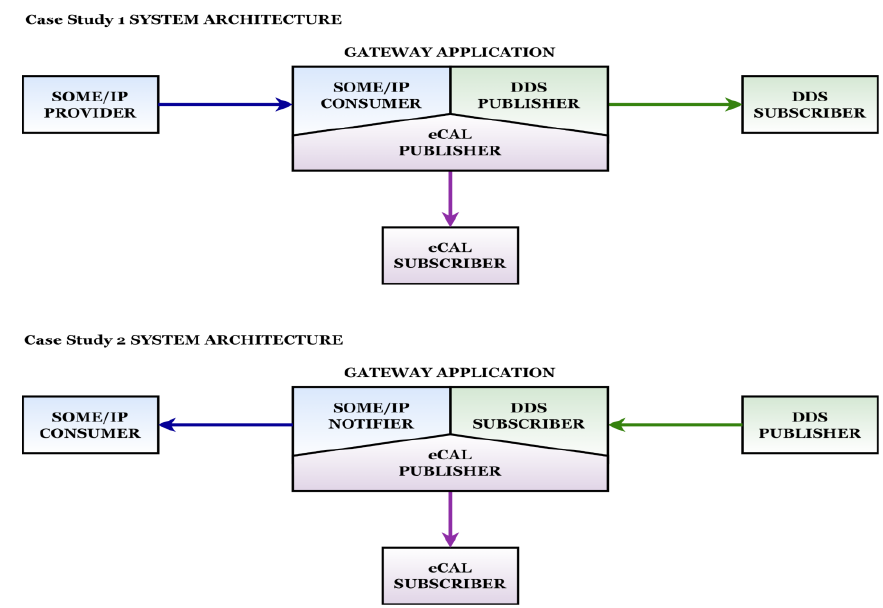
Figure 4. System architecture showcasing both versions of the gateway.